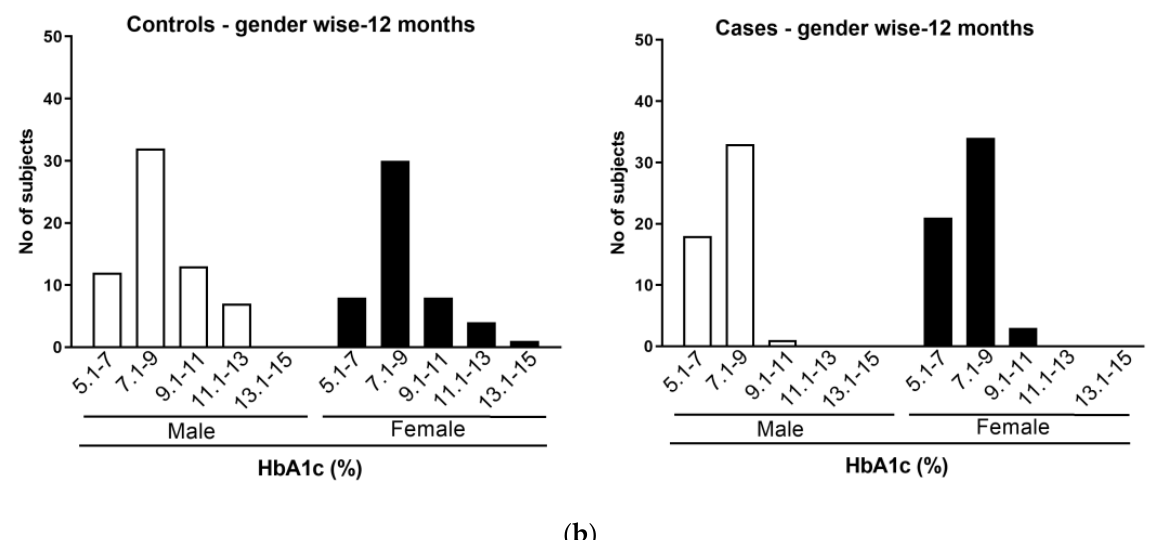
Figure 2. ( a ): Sex-wise distribution of study participants in the control and case groups in RCT: At baseline, the control and case groups of RCT comprised 138 and 135 study participants, respectively. Whereas males (56.5%; n = 78/138) were more predominant in the control group, the females (55.5%; n = 75/135) were more in the case group. ( b ): Distribution of male and female study participants in the control and case groups in the RCT. The male and female study participants of the control and case groups were distributed into different categories based on their HbA1C values. There was a significant difference in the proportion of study participants compared to base line at various time points (4, 8 & 12) at various categories of HbA1c levels among males and females ( p < 0.05 by Chi Square test).